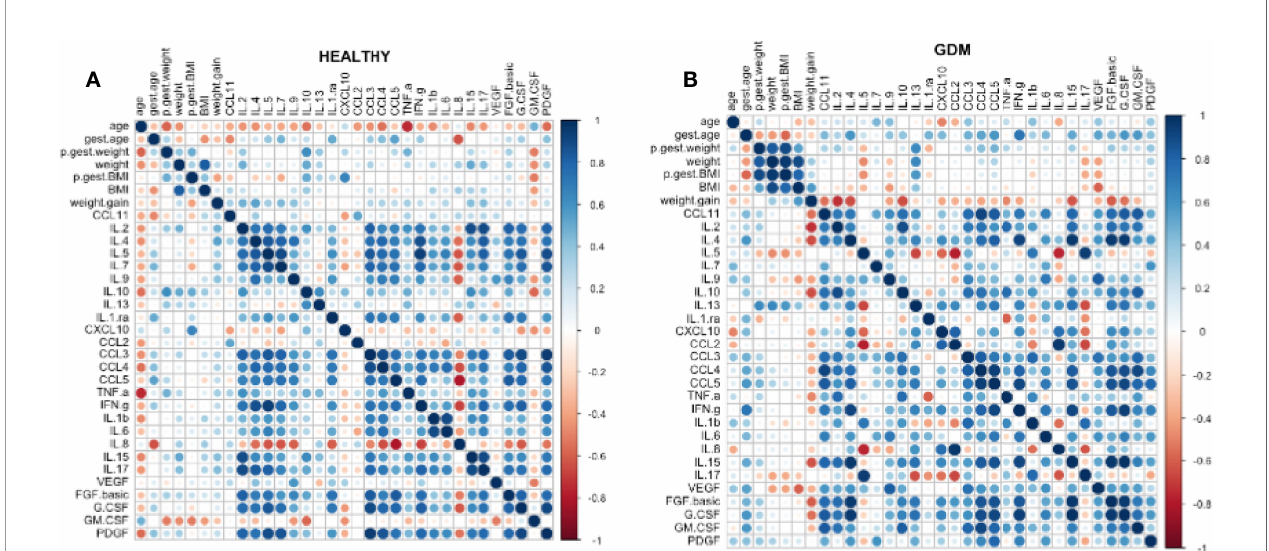
FIGURE 3 | Spearman ’ s correlation was performed to verify the correlation between the 27 bioactive factors measured in the colostrum and the numerical variables. In the healthy group, dot colors are less intense, and we observed a more positive correlation between the bioactive factors themselves (A) . A more signi fi cant correlation between the variables was observed mainly in the group of women who presented with GDM (B) , through the intensity of the colors (more intense blue = stronger correlation). In addition, there is a negative correlation (more intense red = stronger negative correlation) between weight gain and the